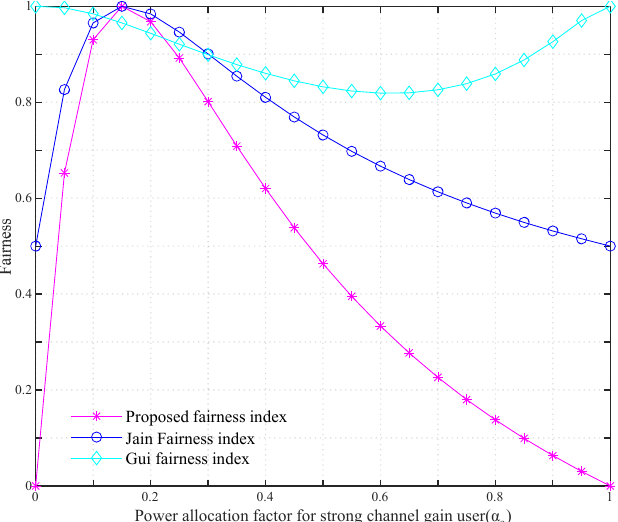
Figure 2. Comparison of fairness indexes ( M = 2).